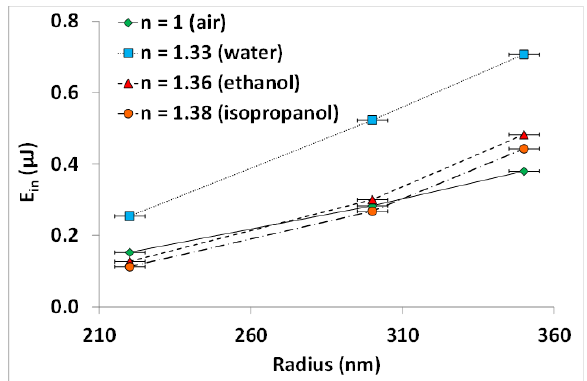
Fig. Pump energy inside the nanofiber at breakdown for different radii and different